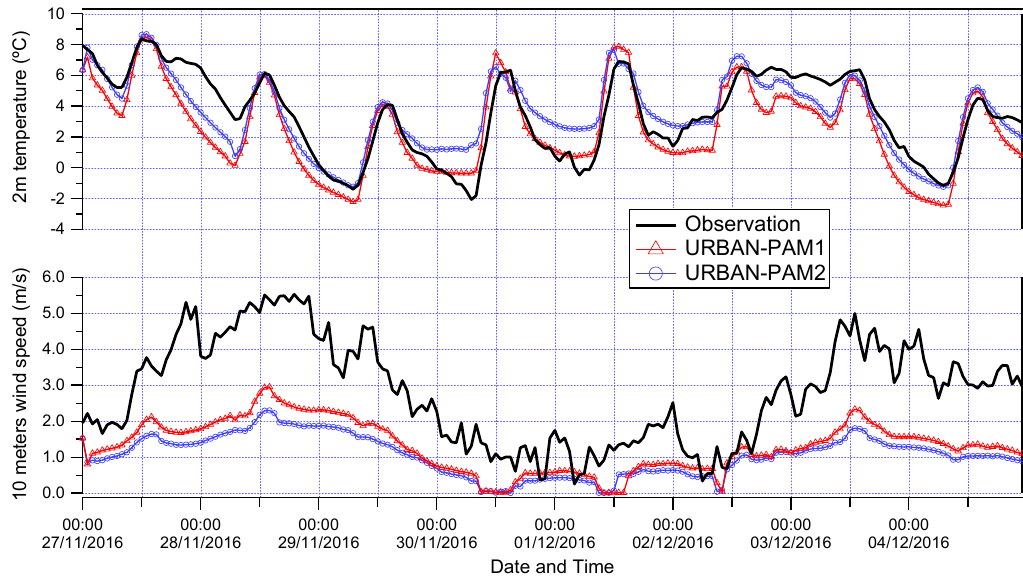
Figure 3. Time series of 2 m temperature and 10 m wind speed at Sirta station.